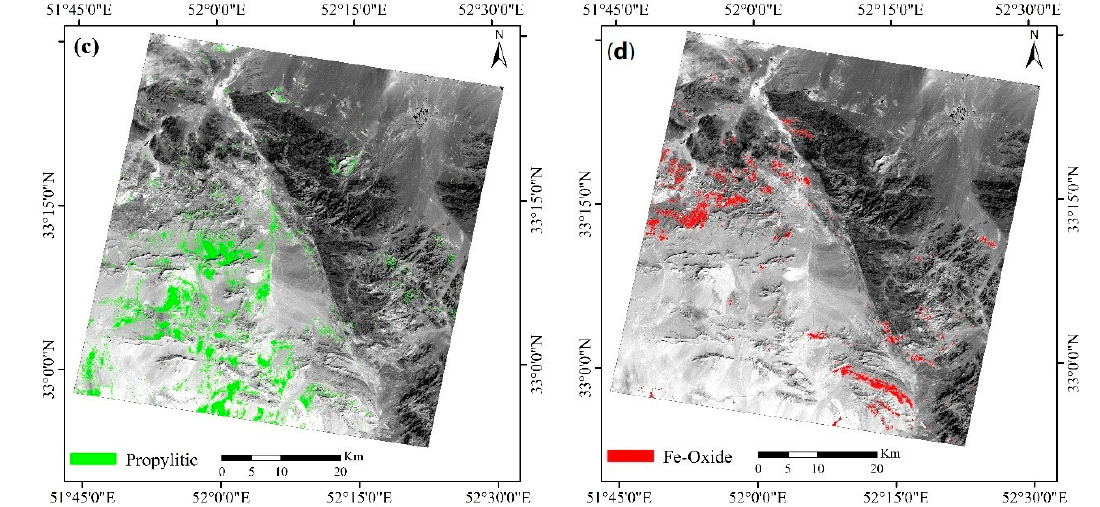
Figure 8. The results of SAM spectral mapping on the ASTER data. ( a ) Argillic alteration, ( b ) phyllic alteration, ( c ) propylitic alteration, and ( d ) Fe-oxide alteration.